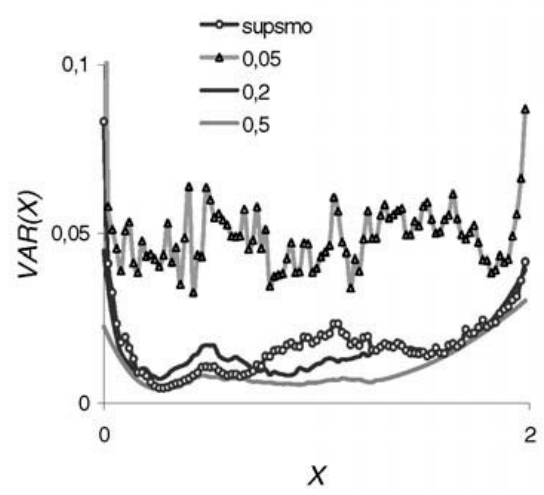
Figura 11 – Modello III: varianza degli stimatori.